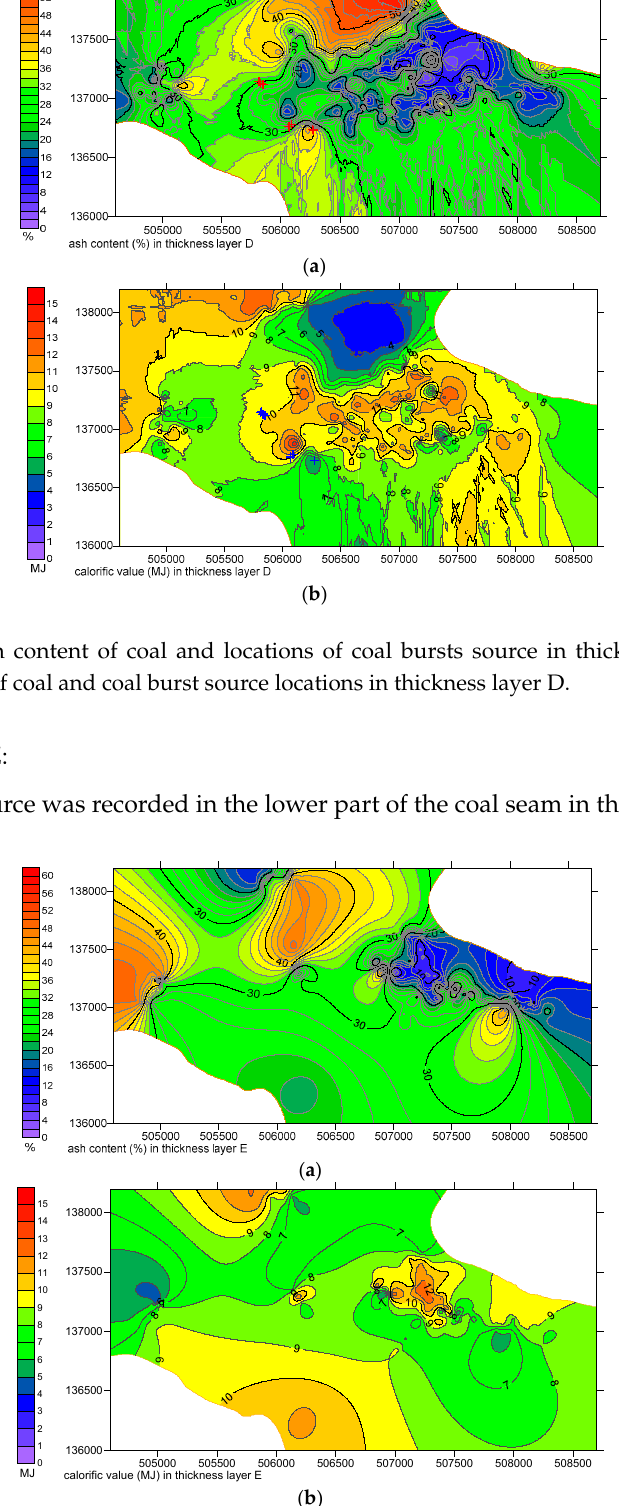
Figure 13. ( a ) Ash content of coal in thickness layer E; and ( b ) calorific value of coal in thickness layer E.